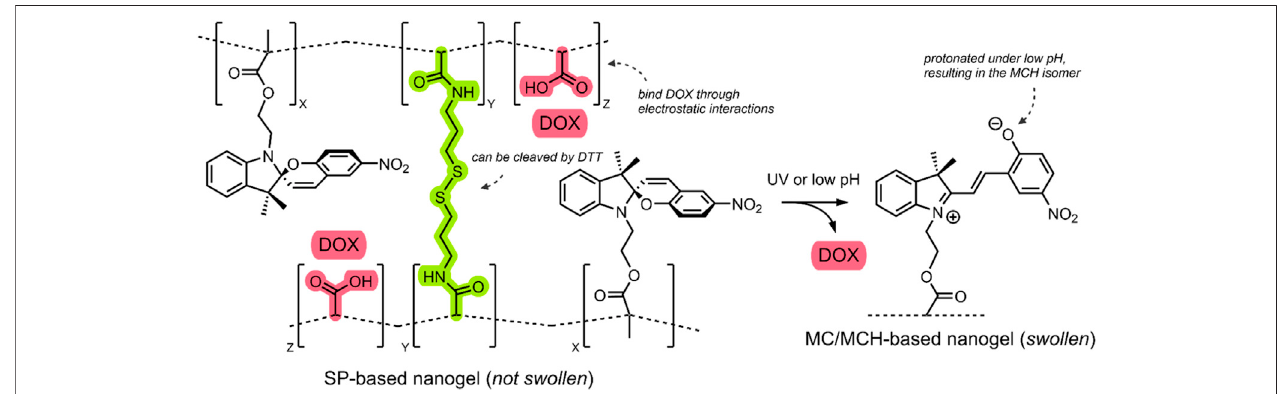
FIGURE 7 | Schematic of the SP-based NG. The SP → MC/SP → MCH isomerisation is shown in response to UV/pH stimuli. The BAC crosslinker and the DOX- binding acrylic acids are highlighted green and red. The NG network was simpli fi ed with dashed lines (Chen et al.,